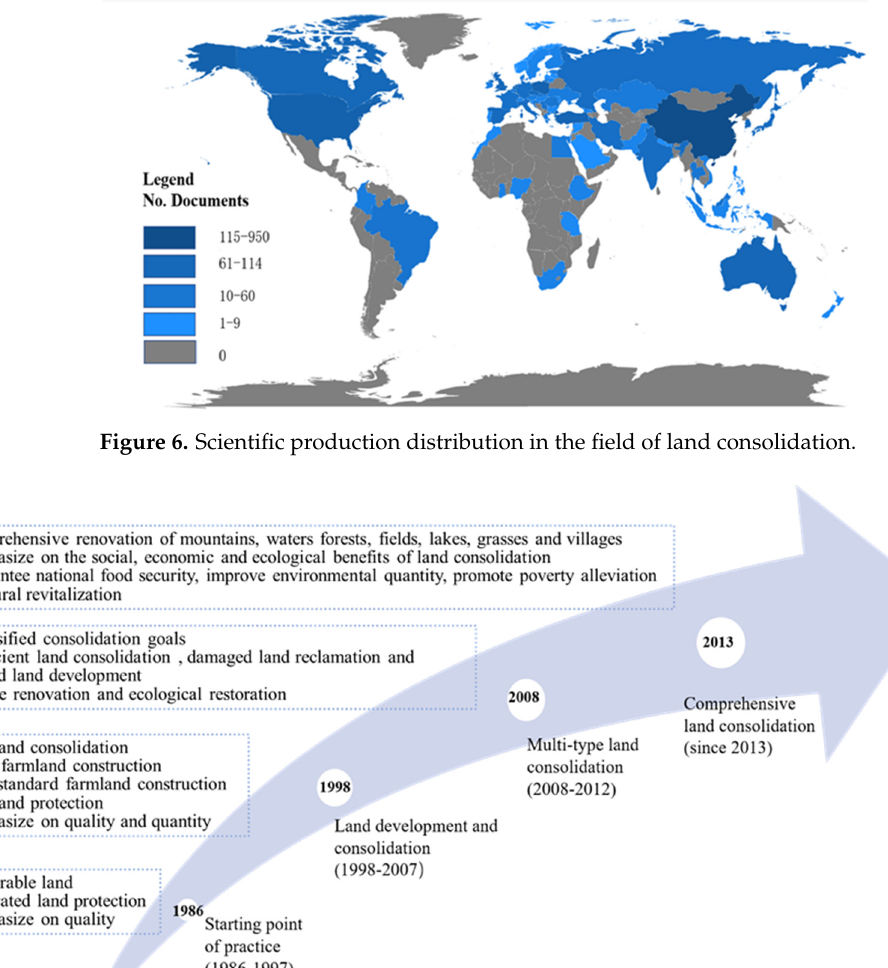
Figure 7. The history of land consolidation in China. Source: Land consolidation and rural revital- ization in China: Mechanisms and paths [43].